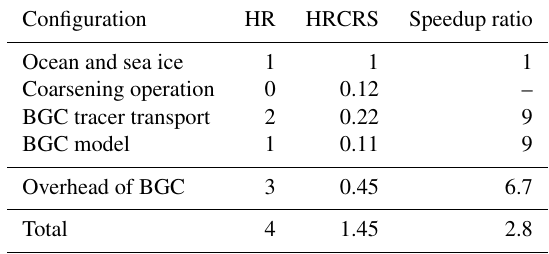
Table 5. Typical expected speedup in elapsed time between a run without versus with multi-grid algorithm. Values have been extrap- olated from the measured cost of the coarsening operation and an estimate of the net overhead of the PISCES biogeochemical (BGC) model. Figure 12. Position of coarsened cells (green) on its high-resolution grid local mpp domain for some odd or even coarsening